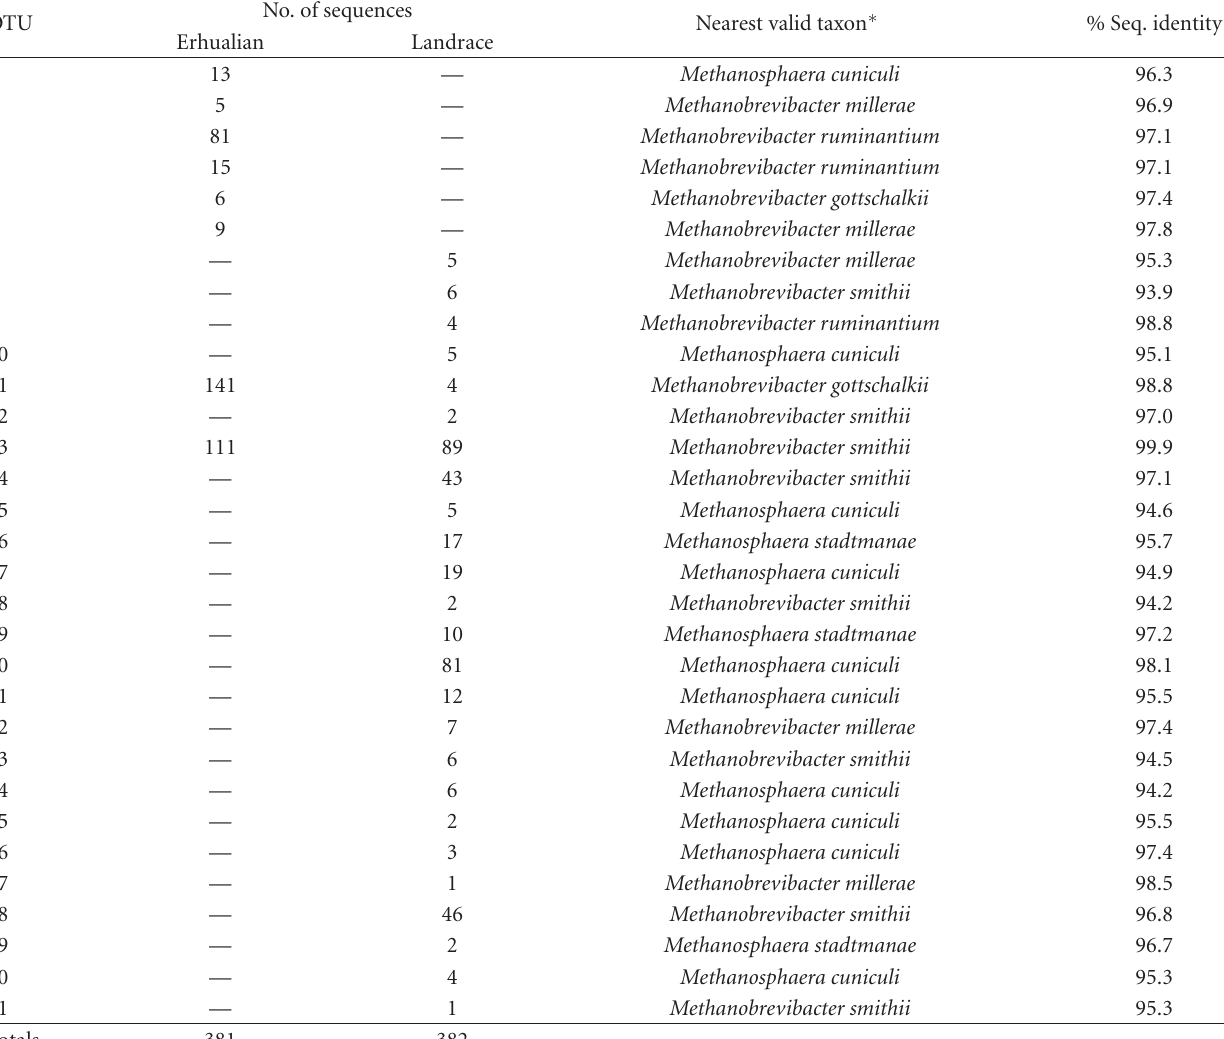
Table 2: Comparison of OTUs between Erhualian and Landrace pigs.